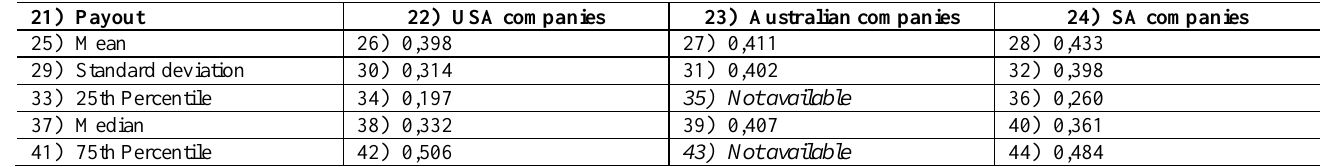
Table 3: Comparison between USA, Australian and SA companies – payout